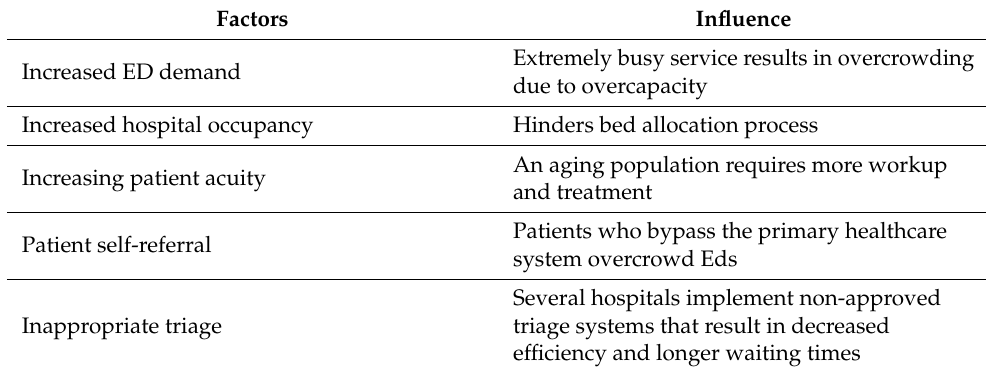
Table 1. Factors affecting crowding in